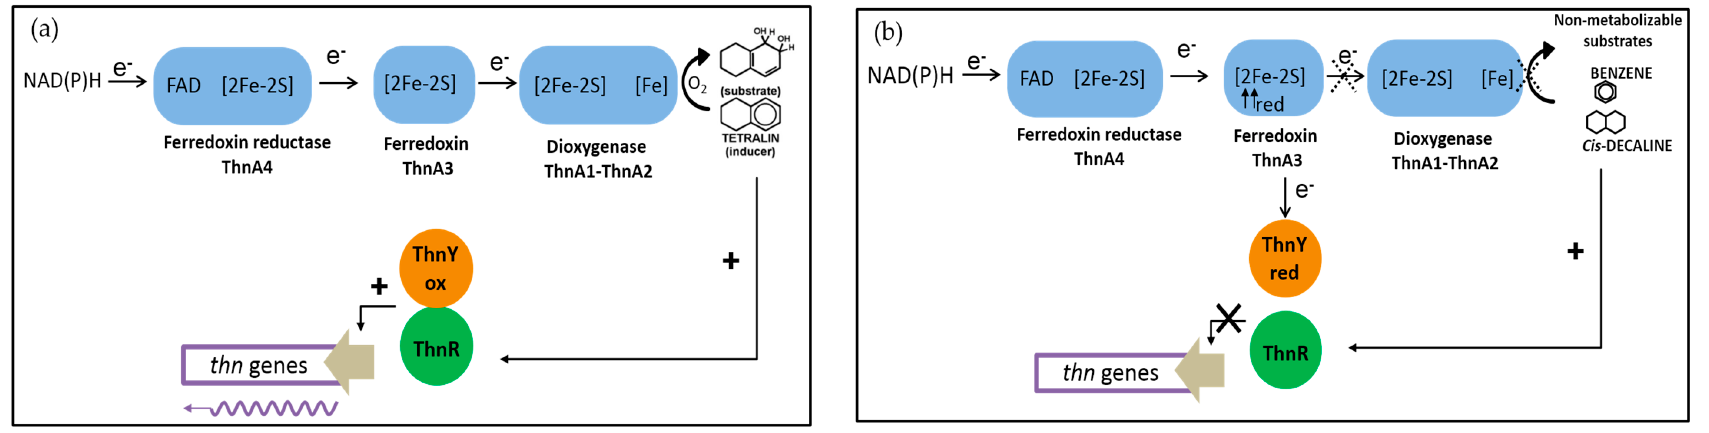
Figure 3. Model for specific regulation and modulation of thn genes transcription in TFA. ( a ) In the presence of the tetralin, electrons are preferentially delivered to the dioxygenase and ThnY ox and ThnR can activate transcription from the inducible thn promoters. ( b ) In the presence of compounds that are non-substrates of the dioxygenase, ThnA3 is accumulated in the reduced state and electrons are redirected towards ThnY instead of the dioxygenase impairing thn genes transcription.